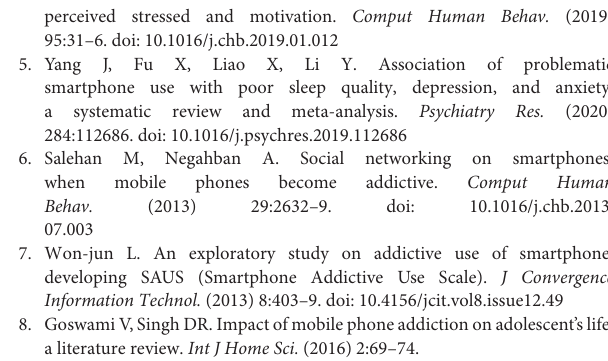
studies using the MPATS having higher correlation coefficients than those using the MPAI or other measurement